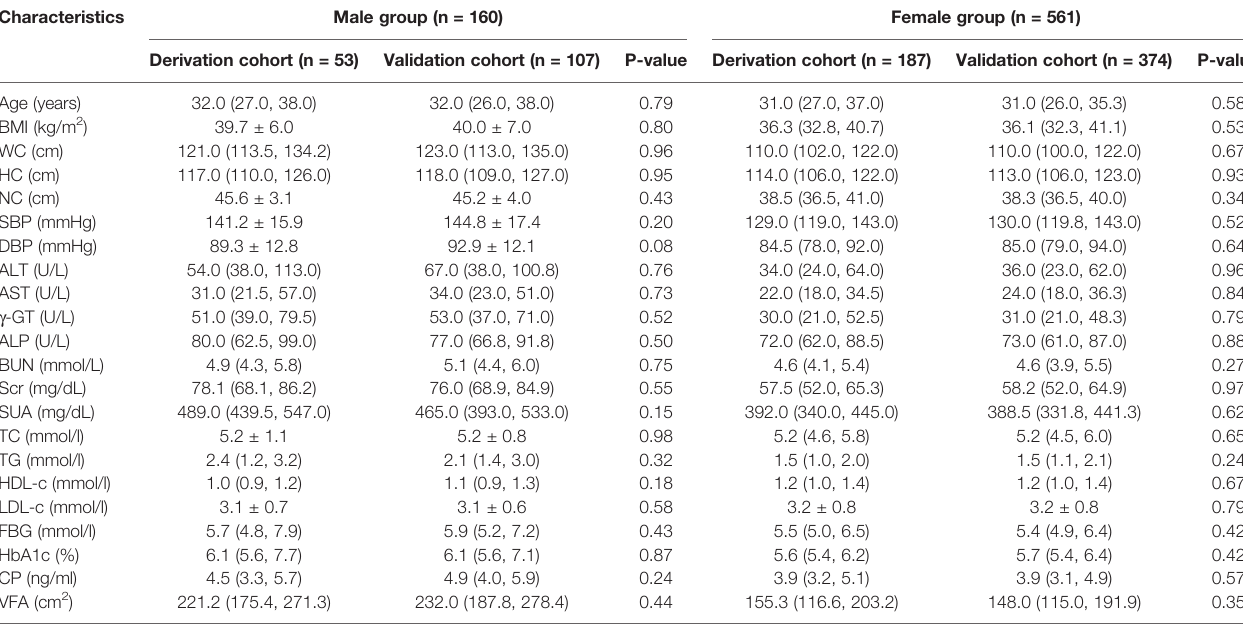
TABLE 1 | Baseline Characteristics in the derivation and validation cohorts.